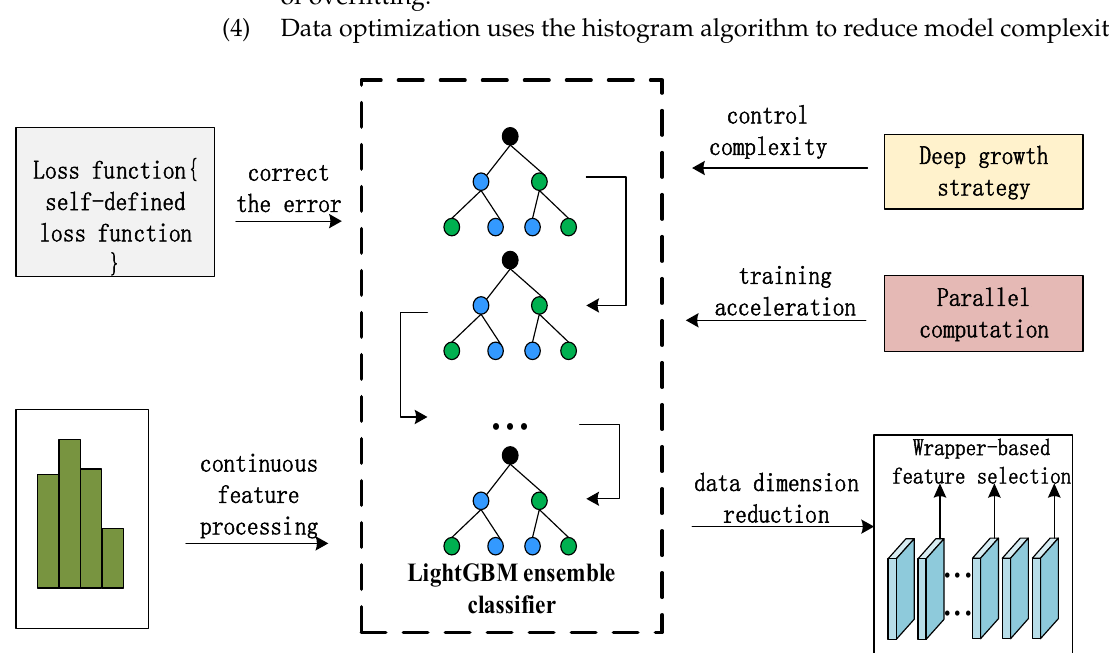
Figure 5. LightGBM optimization strategy.